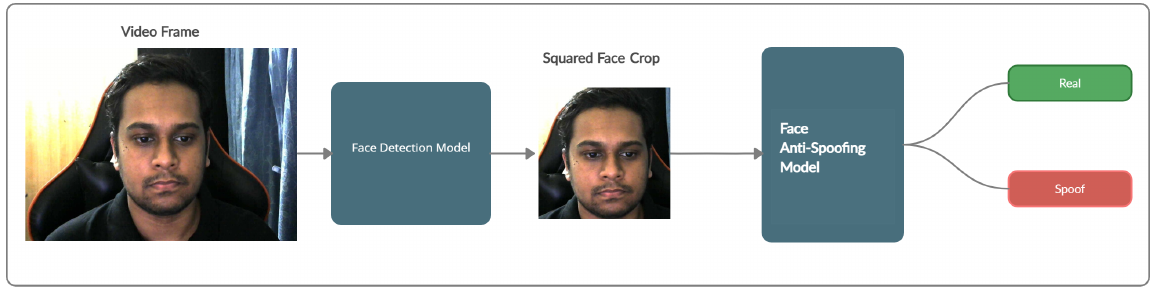
Figure 2. The overview of the proposed